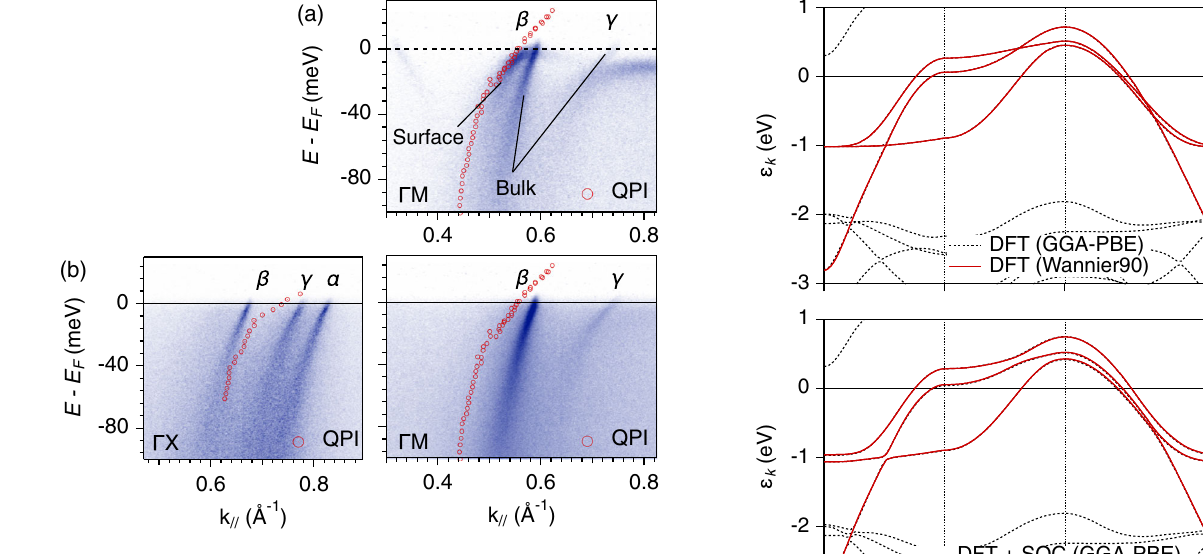
FIG. 8. Comparison with the STM data from Ref. [49]. (a) Γ M high-symmetry cut on a pristine cleave. The bulk β and γ and the surface β bands are labeled. (b) Laser-ARPES data from CO passivated surface showing the bulk band dispersion along Γ X and Γ M. The dispersion obtained from quasiparticle interference in Ref. [49] is overlaid with red markers.